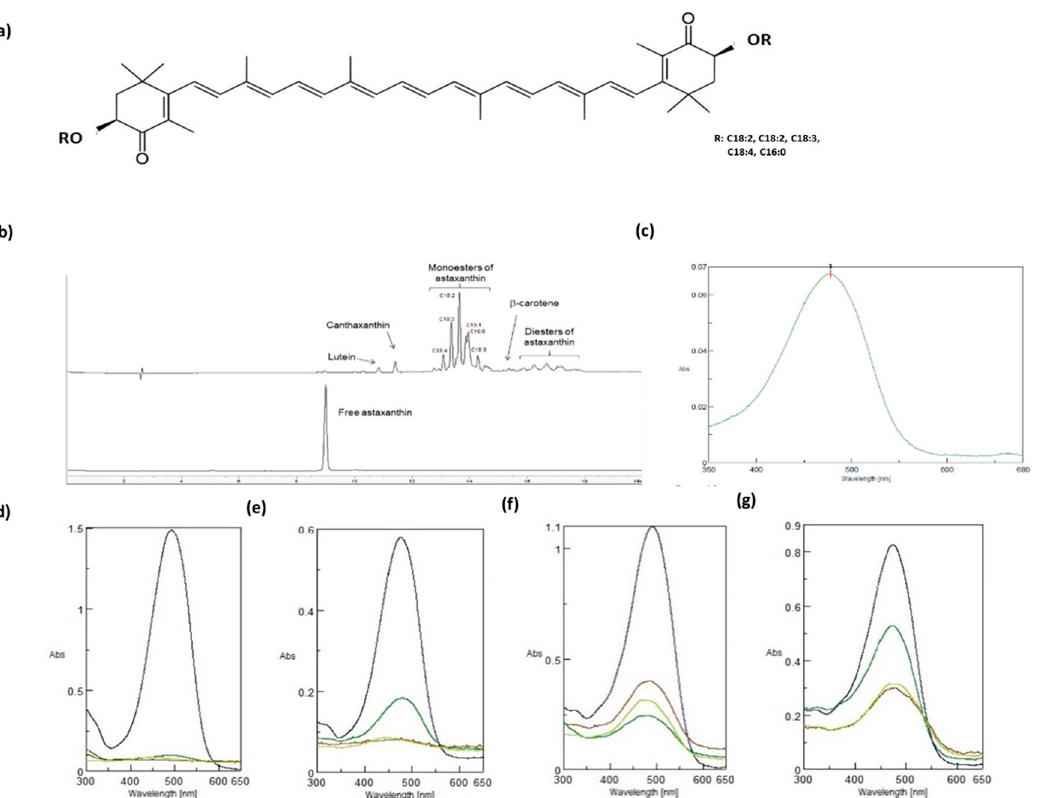
Figure 1. Physical–chemical characteristics of natural astaxanthin (NAst). ( a ) NAst structure and its monoesters. ( b ) HPLC chromatogram of carotenoid-enriched extract from Haematococcus pluvialis (up) and synthetic astaxanthin (down). ( c ) UV-vis spectrum in ethanol of NAst extracted and purified from H. pluvialis . ( d ) UV-vis spectra of synthetic astaxanthin in different DMSO/water mixtures. ( e ) UV-vis spectra of synthetic astaxanthin in different EtOH/water mixtures. ( f ) UV-vis spectra of NAst in different DMSO/water mixtures. ( g ) UV-vis spectra of NAst in different EtOH/water mixtures. Black traces are for 0% water, dark green traces are for 25% water, red traces are for 50% water, and light green traces are for 100% water.